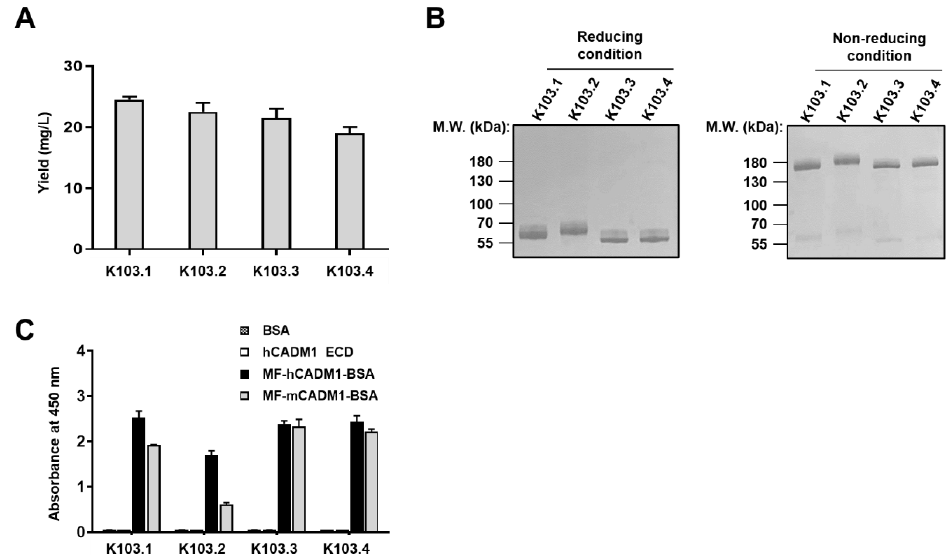
Figure 3. Biochemical characterization of the four selected scFv-Fc antibodies. ( A ) The selected antibodies were transiently overproduced and purified using affinity column chromatography. The production yield of each scFv-Fc antibody was shown as graph bars. ( B ) The conformation status of the scFv-Fcs was confirmed by SDS-PAGE under reducing and non-reducing conditions, followed by CBB staining. ( C ) ELISA was performed with recombinant human CADM1-ECD, MF-hCADM1-BSA, or MF-mCADM1-BSA to verify the specific binding of each antibody to MF-CADM1. BSA alone was used as a negative control.